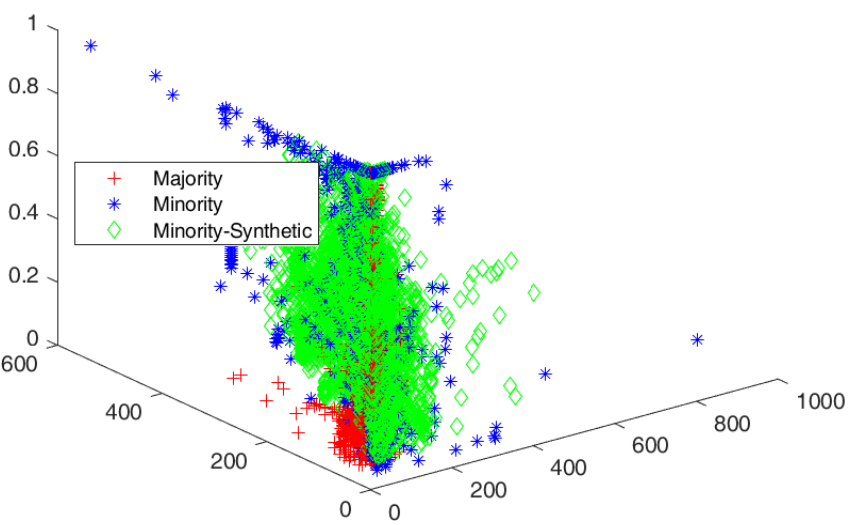
Figure 7. Cluster view of data distribution in cluster among majority and minority for the proposed SMOTE-PSOEV for Page Blocks0 dataset.